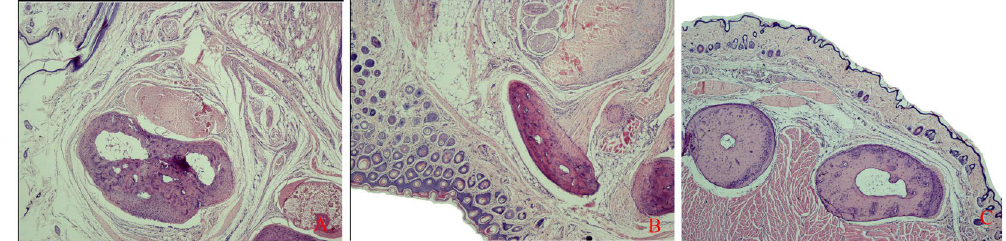
Figure 6. H&E staining of biopsies from different segmental sections of ectopic implantation forelimbs. ( A ) Biopsy was harvested from the forelimb. ( B ) Biopsy was harvested from the forearm. ( C ) Biopsy was harvested from the